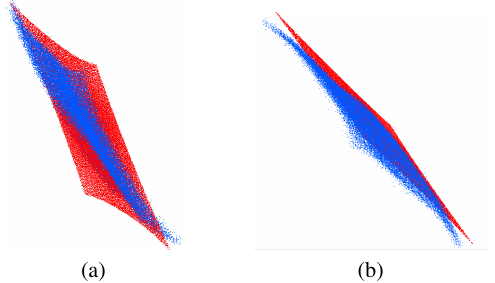
Figure 13. Point cloud of the calibration plane generated by the camera (in blue) and reference plane (in red). (a) obtained by Helmert 3D transformation (b) after alignment of the normal to the planes in Fig. 13(b). Finally, a linear regression is performed on each pixel between the reference planes and the ToF camera cloud. As